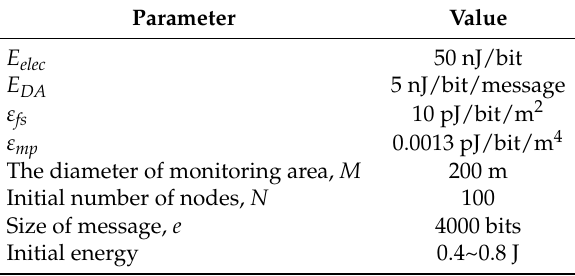
Table 1. Simulation